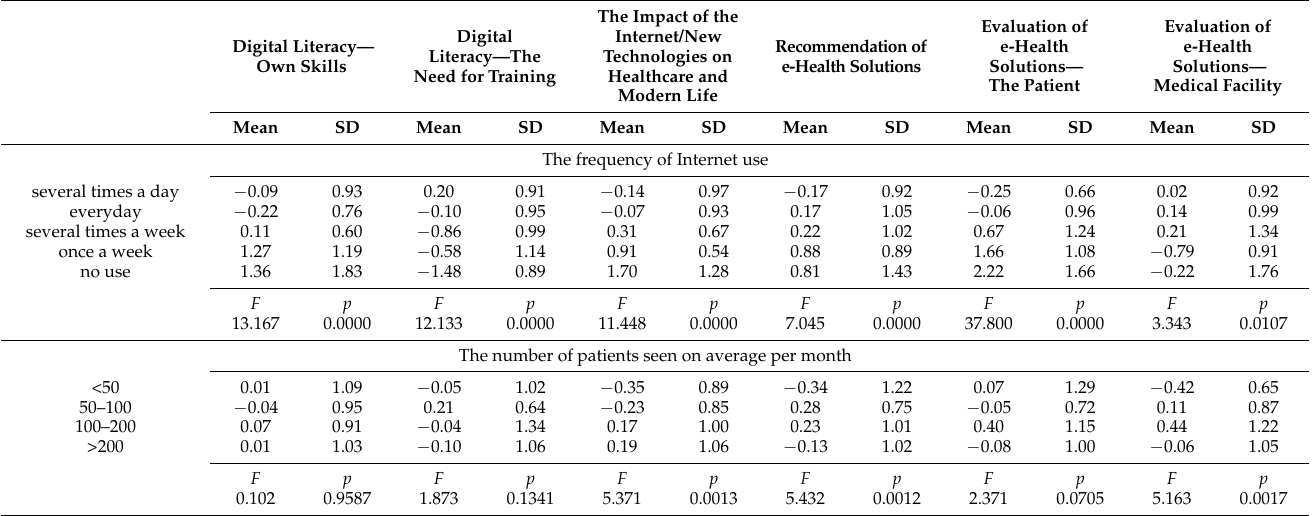
Table 3. Correlations between: the frequency of Internet use and the number of patients seen on average per month by physicians, as well as digital and e-Health selected